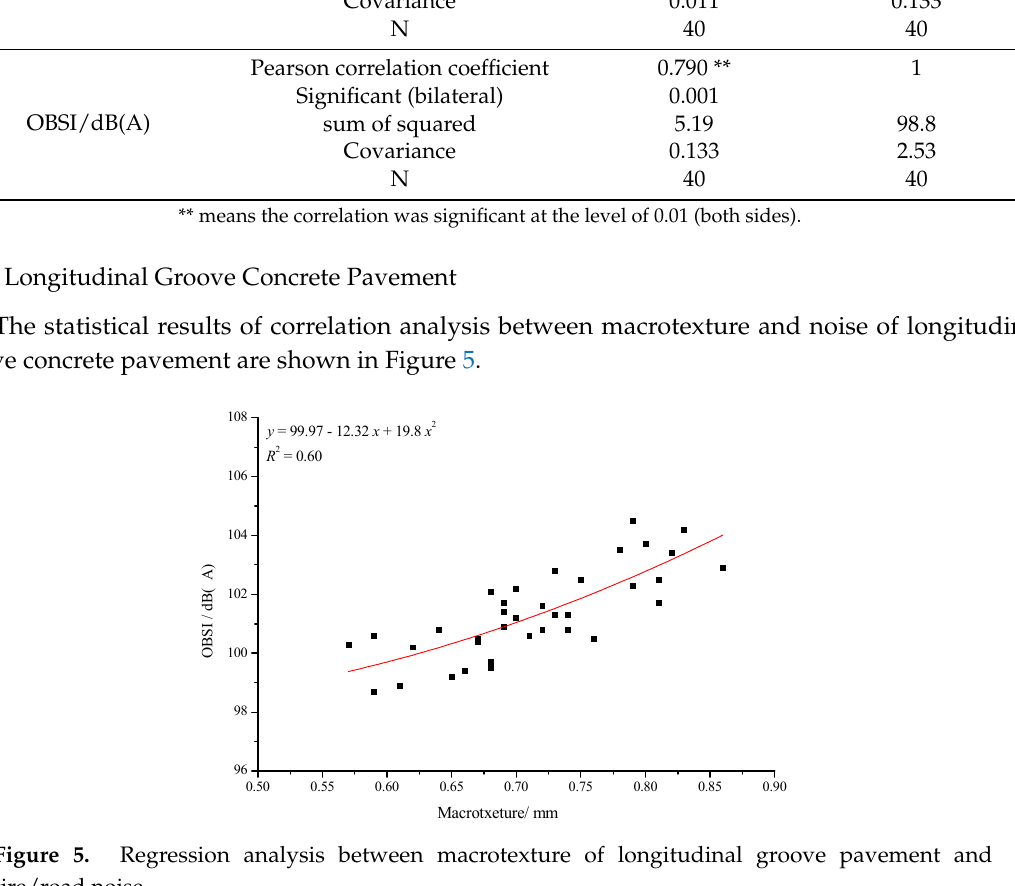
Table 5. Correlation analysis between macrotexture and noise of transverse groove concrete pavement.